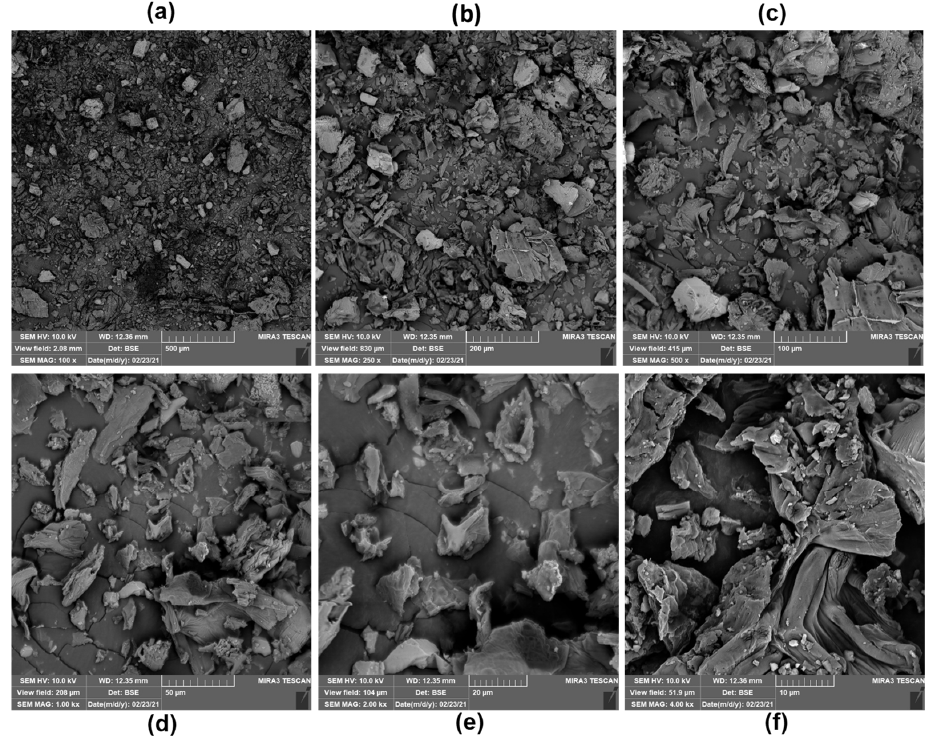
Figure 1. MF micrographs at 100× to 4000× magnification performed in SEM. Magnifications: ( a ) 100×, ( b ) 250×, ( c ) 500×, ( d ) 1000×, ( e ) 2000× and ( f ) 4000×